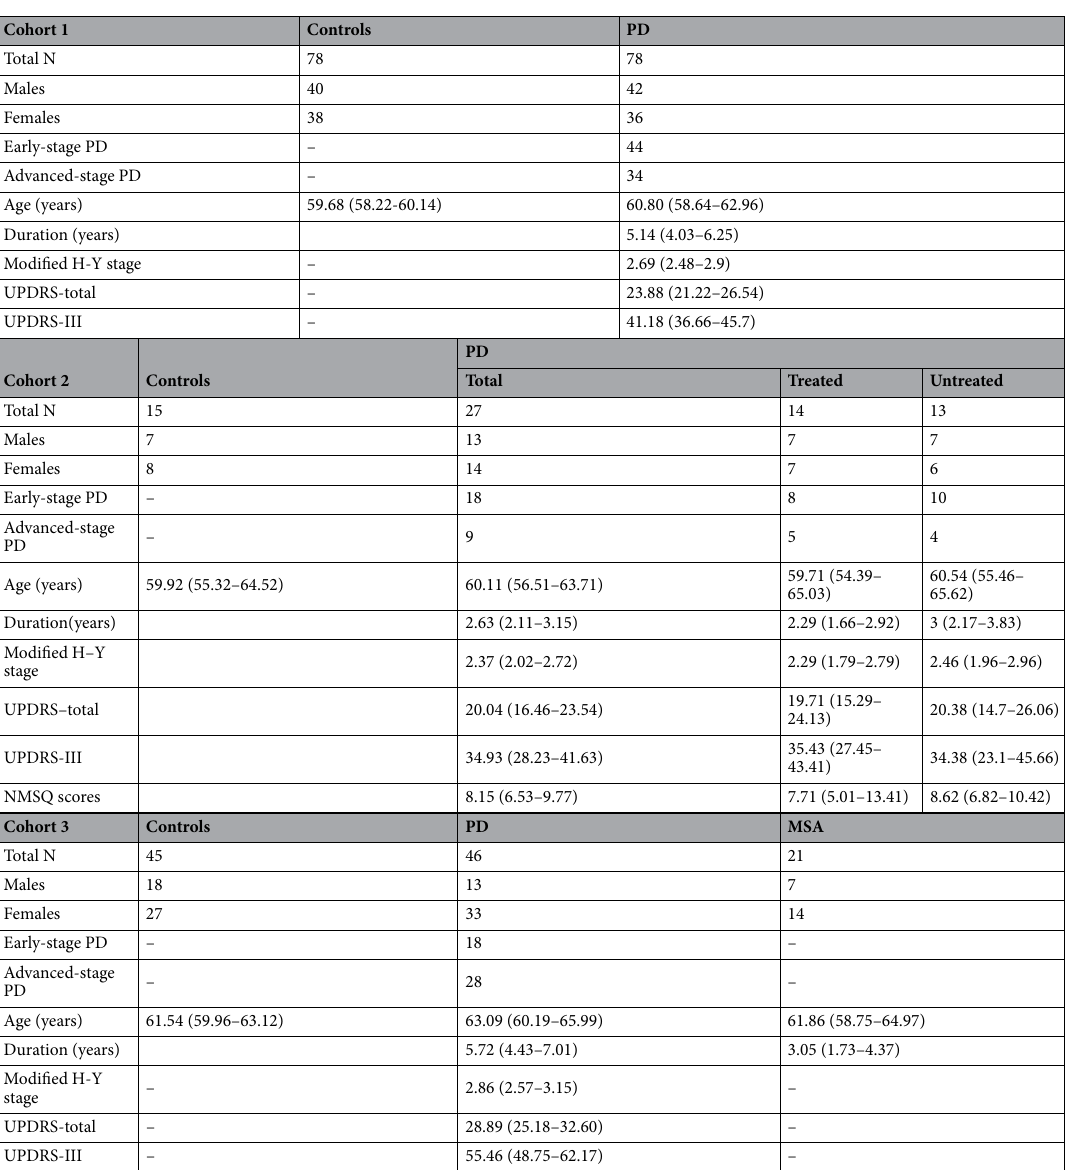
Table 1. Demographic and clinical characteristics. PD, Parkinson’s disease; H-Y stage, Hoehn and Yahr stage; UPDRS, Unified Parkinson’s Disease Rating Scale; UPDRS-III, Unified Parkinson’s Disease Rating Scale Part III; NMSQ, nonmotor system questionnaire ; early-stage PD, modified H-Y stage 1–2.5; advanced-stage PD, modified H-Y stage